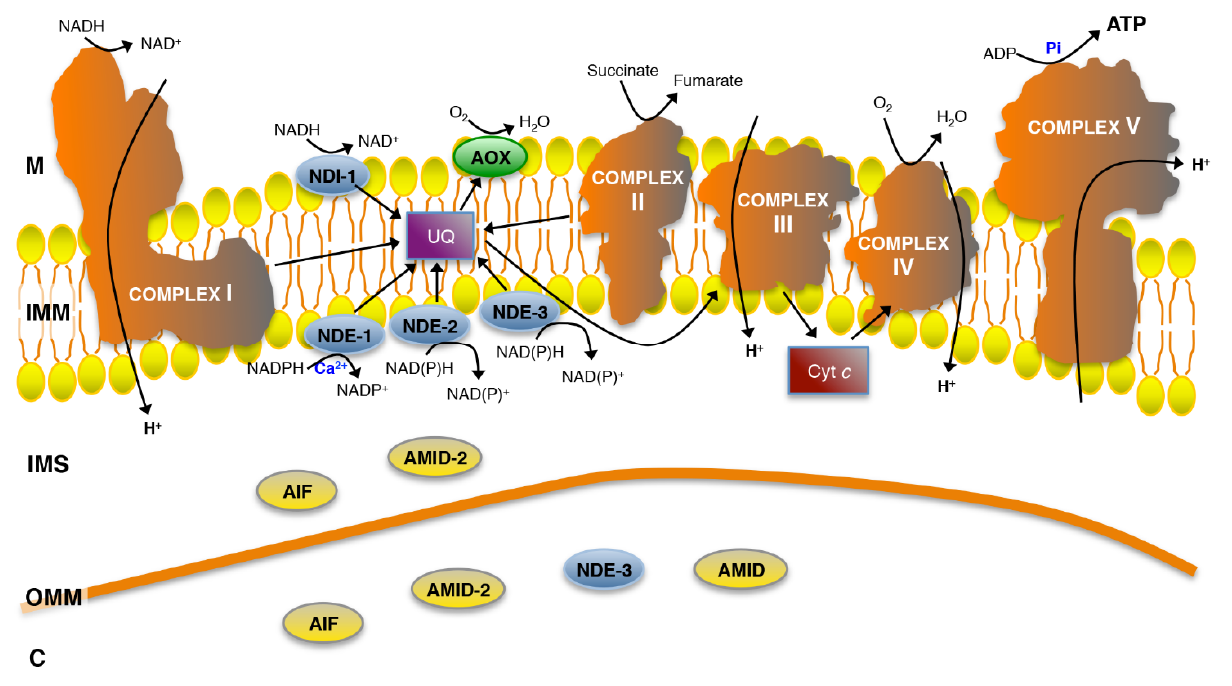
FIGURE 1: Representation of the mitochondrial respiratory chain, alternative NAD(P)H dehydrogenases, alternative oxidase systems and AIF-family proteins of N. crassa . M: mitochondrial matrix; IMM: mitochondrial inner membrane; IMS: intermembrane space; OMM: mito- chondrial outer membrane; C: cytosol; UQ: ubiquinone; Cyt c : cytochrome c